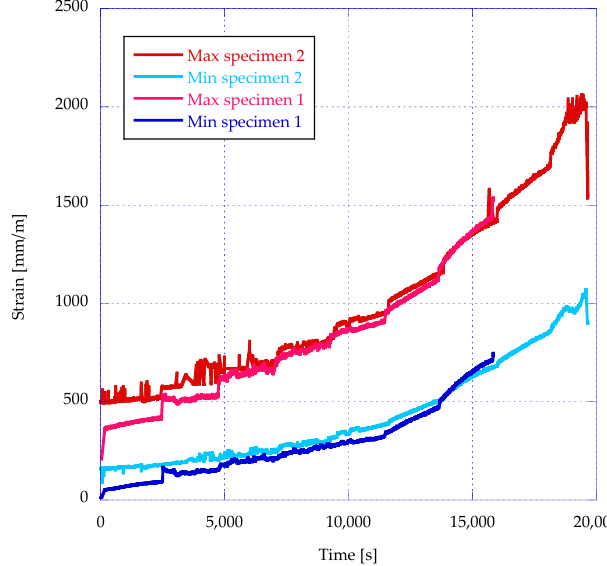
Figure 6. Evolution of the maximum and minimum strain for the LLC mix.